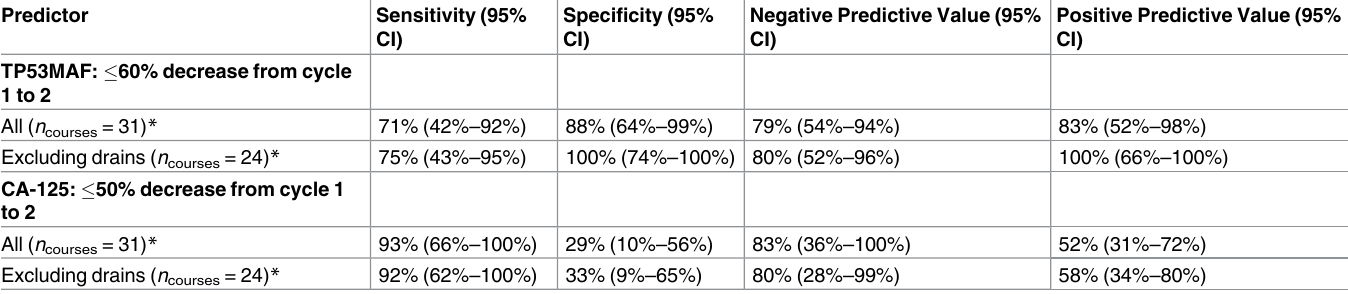
Table 4. Sensitivity and specificity of a decreasein TP53 mutant allele fraction and CA-125for predicting 6-mo time to progression following one cycle of